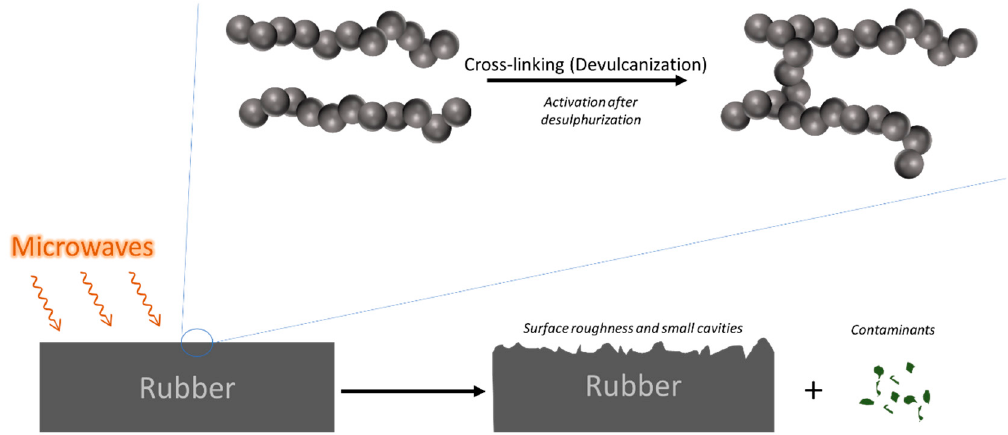
Figure 9. Simplified scheme of the microwaves effect on rubber surface.